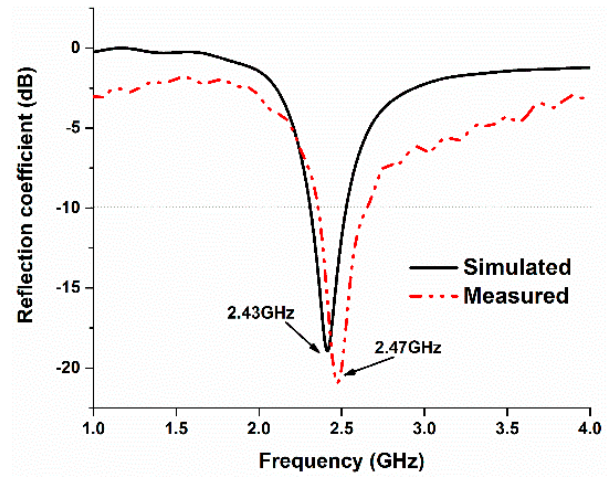
Figure 7. Simulated and measured reflection coefficients of the proposed antenna.